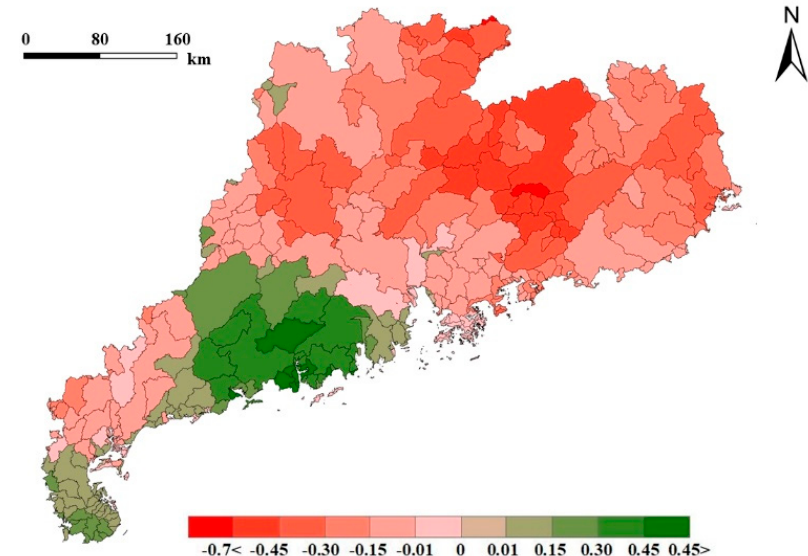
Figure 9. Spatial patterns of the propensity score (SLOPE) for CRIRs in Guangdong.